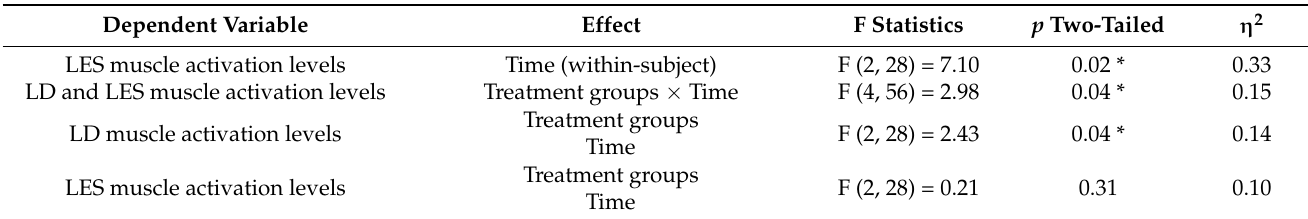
Table 7. Mixed-design repeated measures ANOVA test results with the lateral bending posture (30 ◦ left lateral flexion).